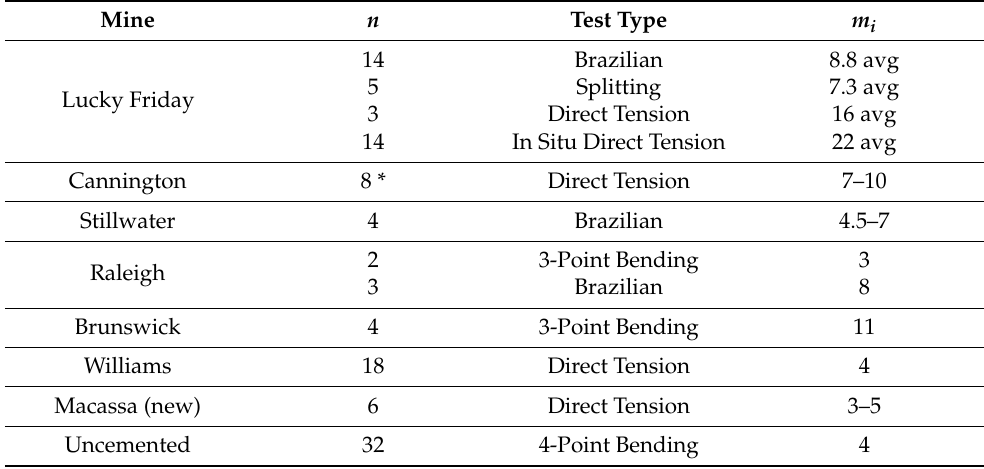
Table 1. Summary of m i = UCS / σ t for various mines. n is the number of datapoints in the dataset. Mine n Test Type m i Lucky